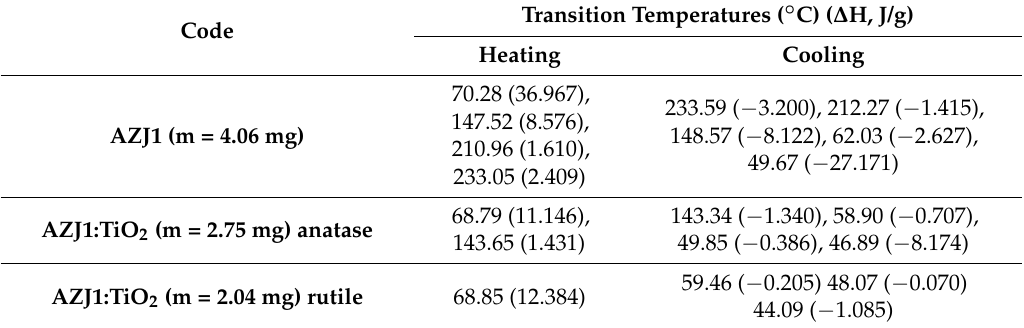
Table 1. Transition temperatures and associated enthalpy changes of AZJ1 and AZJ1:TiO 2 upon heating and cooling at a rate of 10 ◦ C/min.